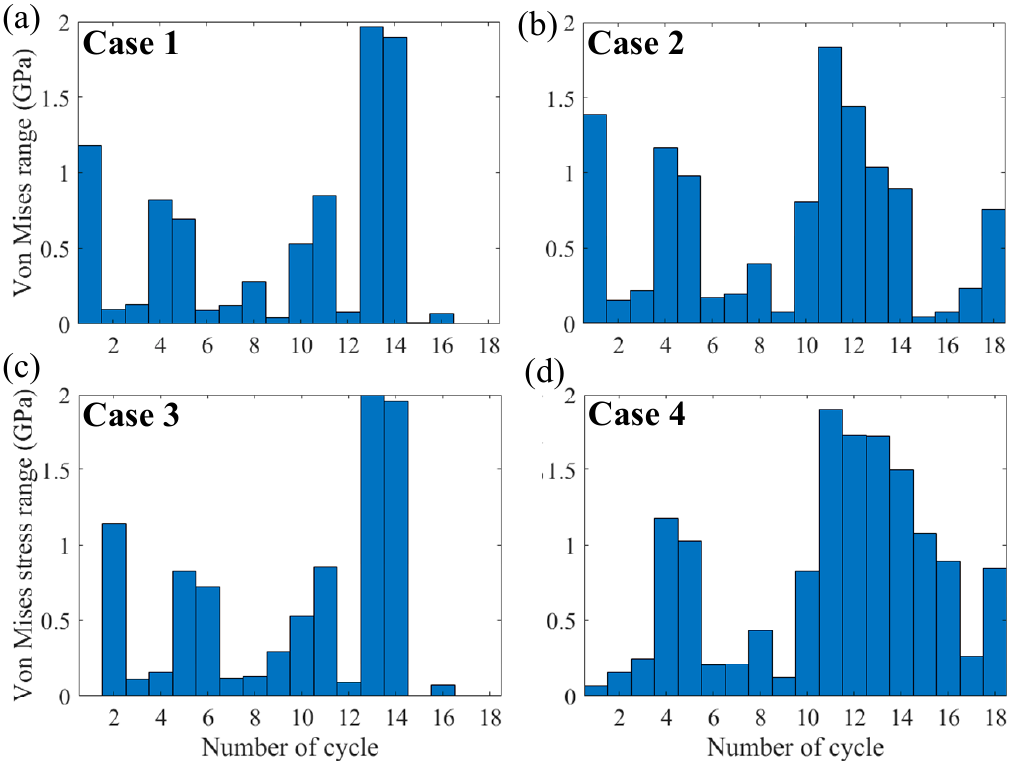
Figure 14. Stress range of Cases 1–4 after 10 million cycles.